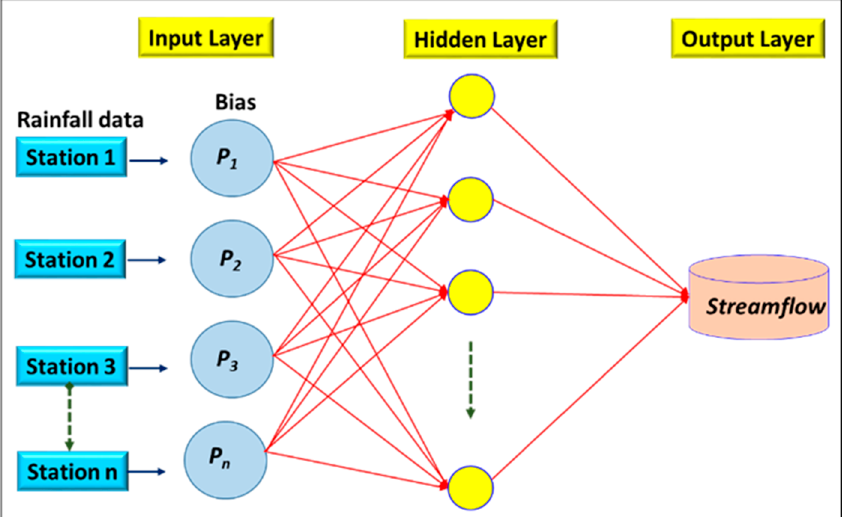
Figure 3. Arrangement of the ANN used in this study.